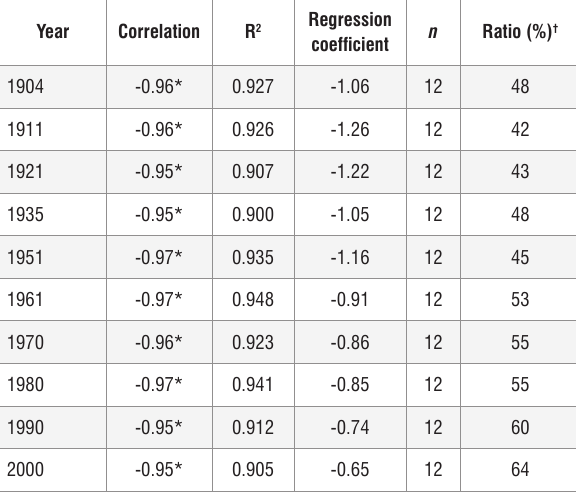
Enterprise number rank-size distributions of Eastern Cape Karoo towns for the period 1904 to 2000. Towns were ranked according to enterprise numbers, which were regressed as log values against log values of rank numbers. 10 10